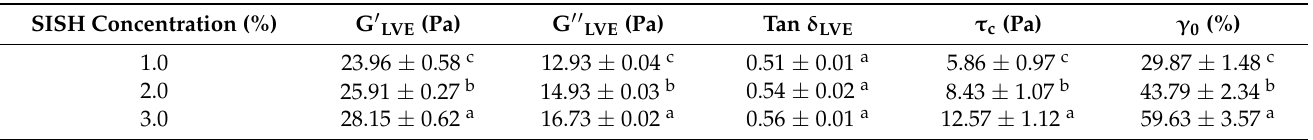
Table 2. Viscoelastic parameters calculated by strain sweep test at 1.0 Hz for SISH dispersions at different concentrations (1, 2, and